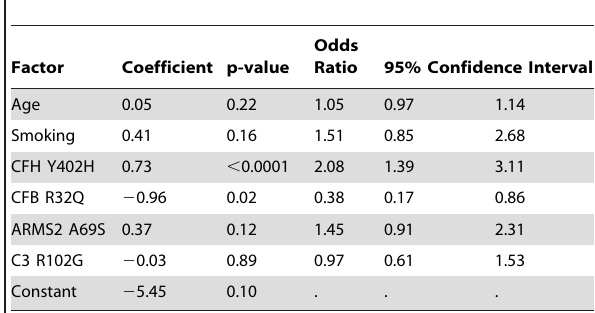
Table 7. Logistic regression model in the ARMA dataset.